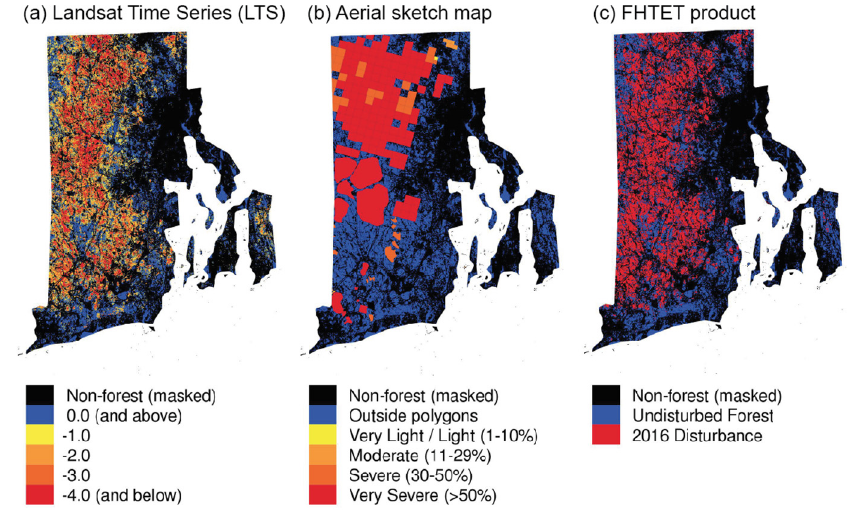
Figure 7. Map-based comparison of 2016 defoliation estimates for Rhode Island, USA. ( a ) The LTS product captures fine resolution patterns of damage and provides a metric of defoliation magnitude; ( b ) The aerial sketch map is coarse resolution, but provides a metric of defoliation magnitude; ( c ) The FHTET product is fine resolution, but does not provide a metric of defoliation magnitude.